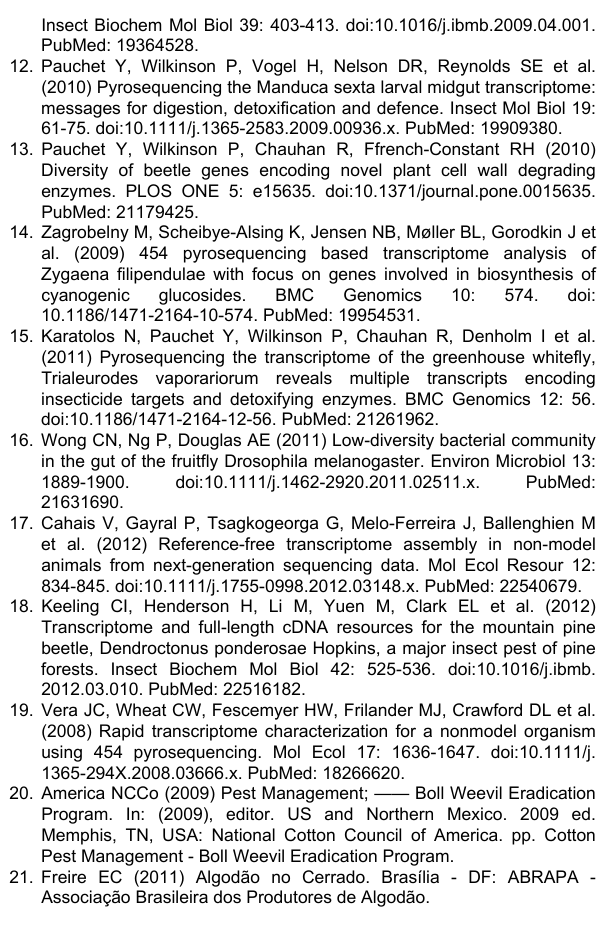
Table S1. A. grandis contigs found in the transcriptome corresponding to RNAi insect genes. RNAi mechanism in